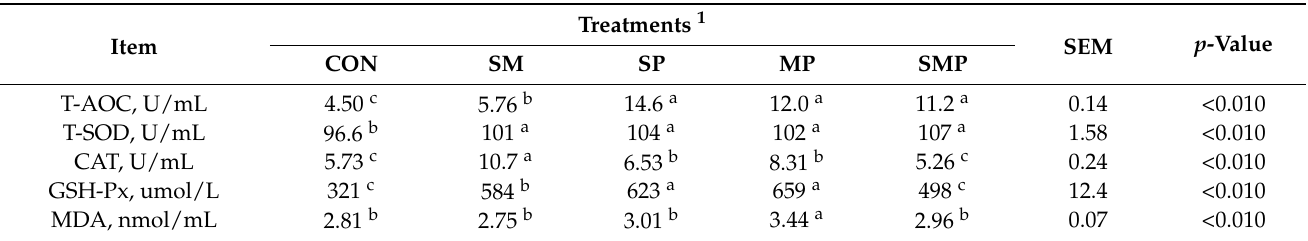
Table 6. Effects of supplementing the diets with different combinations of SB, MCFAs, and omega − 3 PUFA on antioxidant capacity in the plasma of suckling piglets.